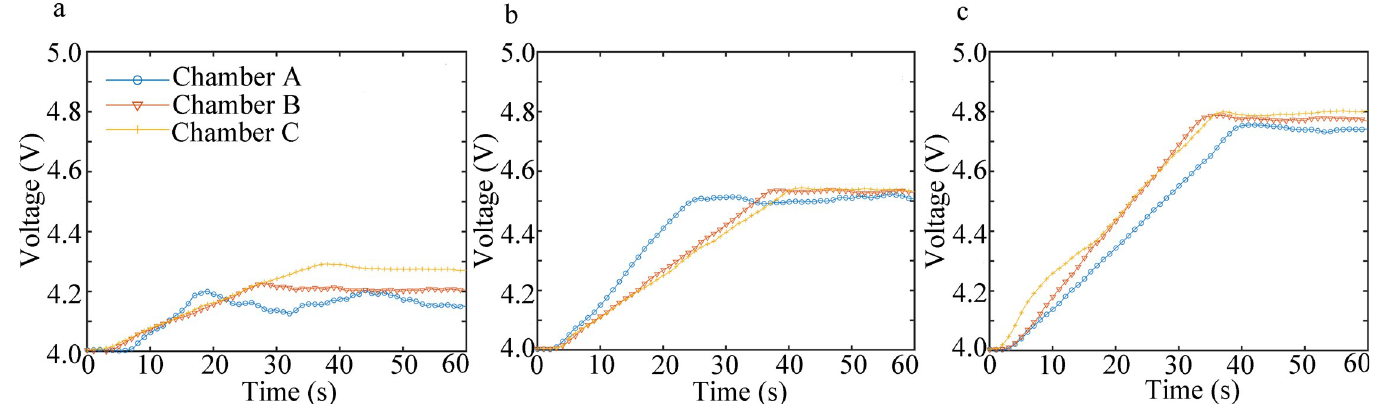
Fig 7. Voltage response mean plots of the three bionic sensing systems under three NO gas concentrations: (a) 15 ppb, (b) 30 ppb, and (c) 45 ppb.